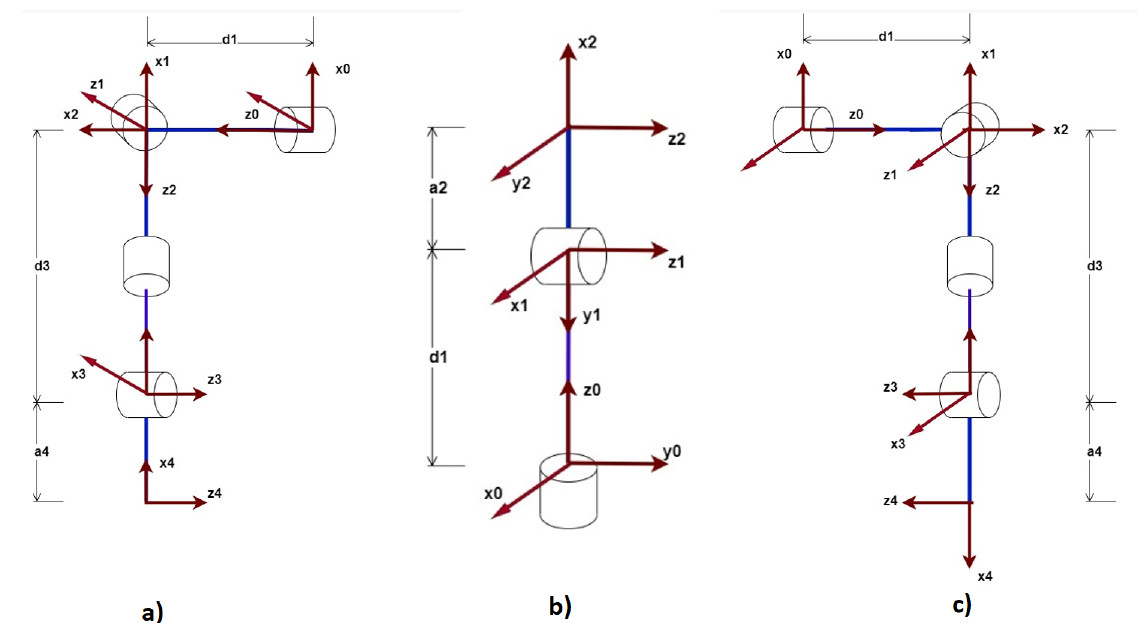
Figure 8. Denavit-Hartenberg analysis of arms and head ( a ) Right arm D-H analysis with 4 DOF; ( b ) Head D-H analysis with 2 DOF; ( c ) D-H analysis of left arm with 4